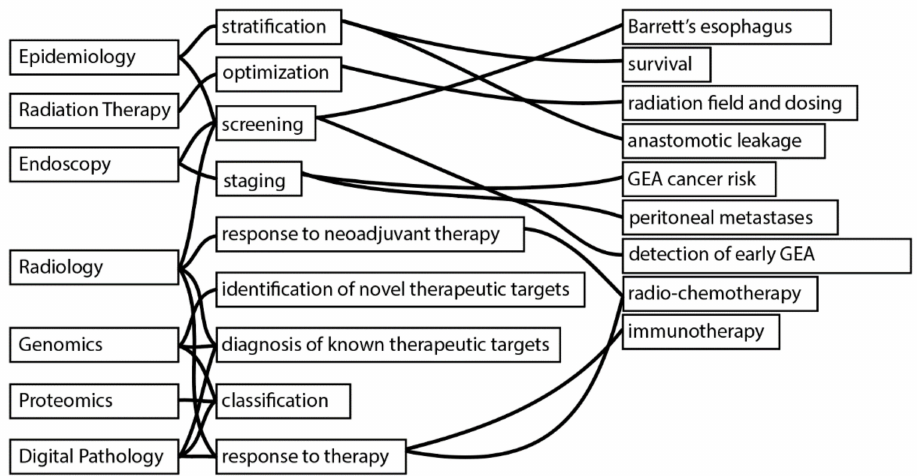
Figure 3. ML applications according to medical disciplines and diagnostic modalities in GEA. A description of studies following the given examples can be found in Sections 2.2.1–2.2.5. In